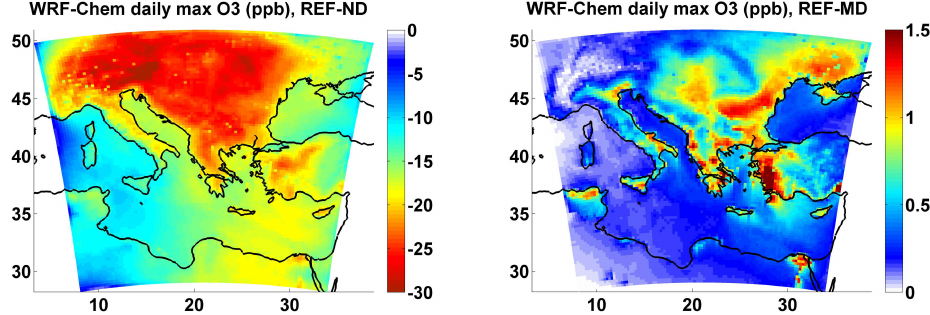
Fig. 14. Change in daily maximum near-surface ozone (ppbv) due to dry deposition (REF-ND) (left) and due to high temperatures (above 28 ◦ C) in the computation of dry deposition (REF-MD) (right), calculated by WRF-Chem and averaged over the summer (JJA) 2007.